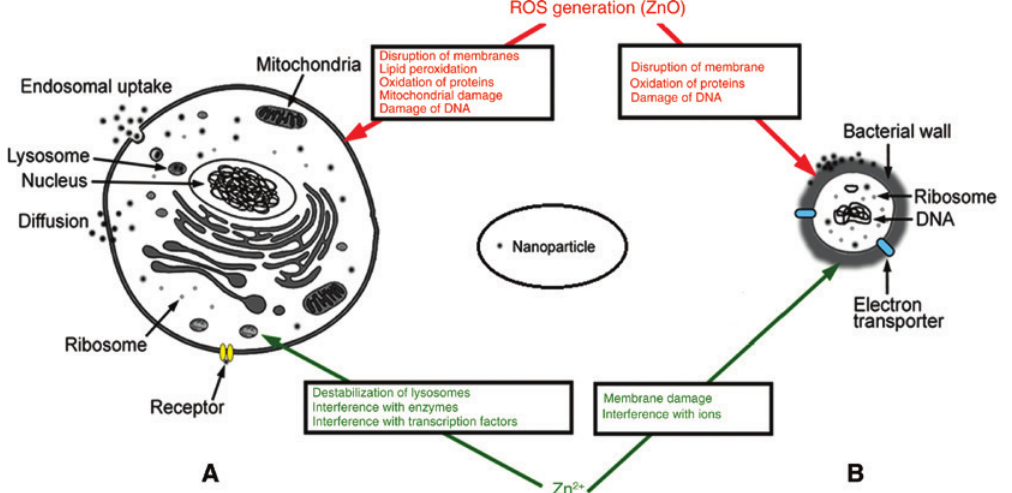
Figure 7: ROS generation on eukaryotic (A) and prokaryotic (B) cells by ZnO NPs